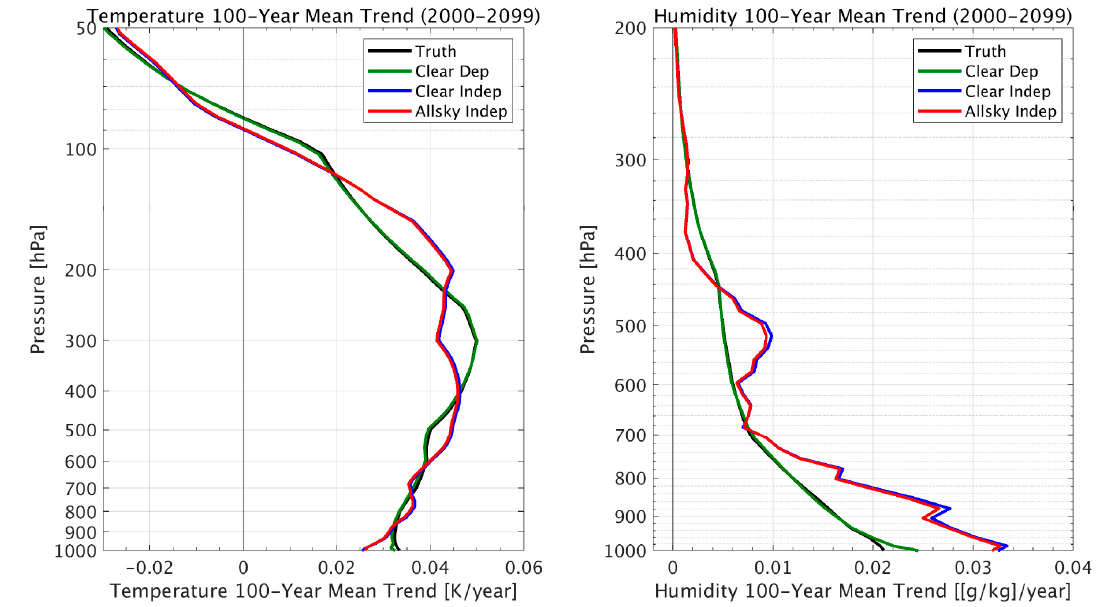
Figure 6. Comparison of retrieved global temperature (left) and humidity (right) trends with climate model observing system simulation experiment (OSSE) global trends for the 100-year period 2000–2099.